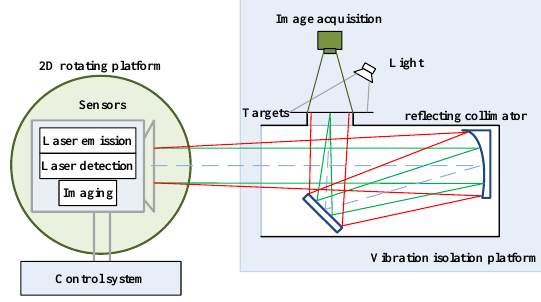
Figure 4. Schematic diagram of calibration